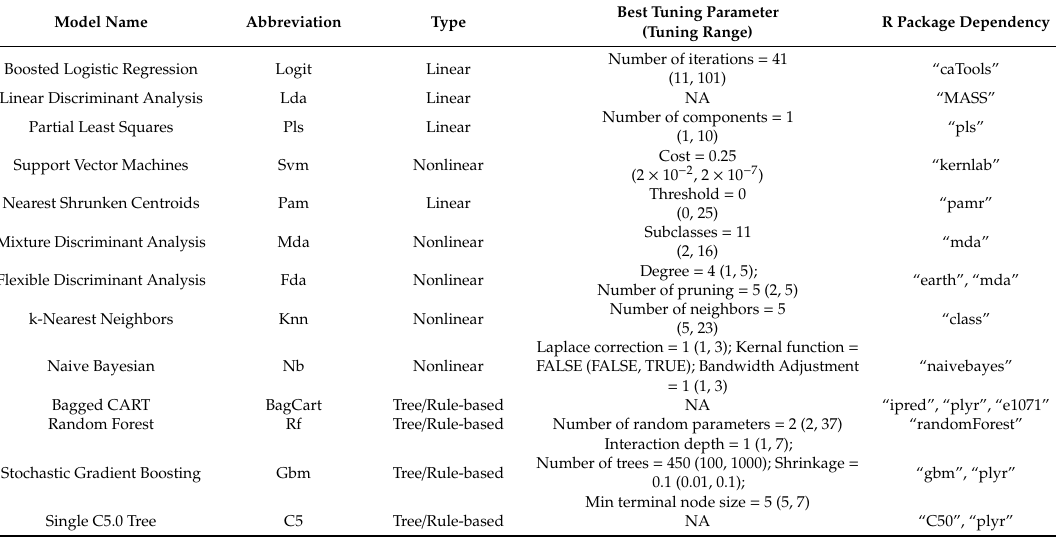
Table 2. Summarization of model names, types and tuning